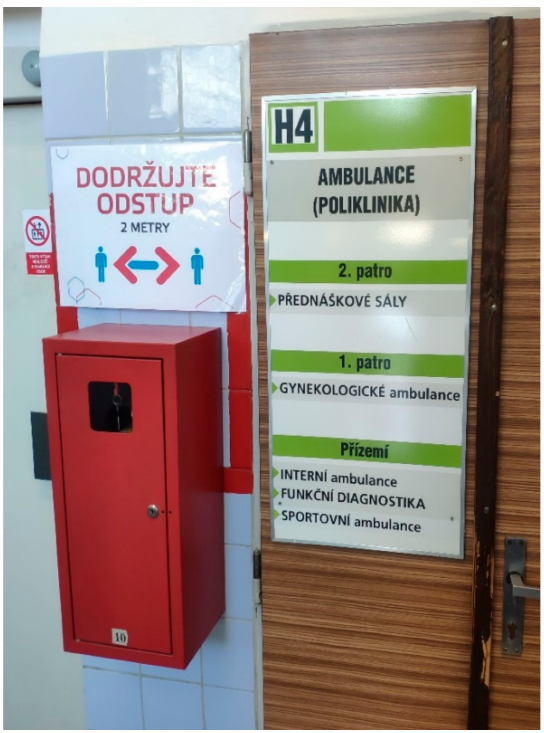
Figure A1. Door signs in the V í tkovice Hospital (10/2020).